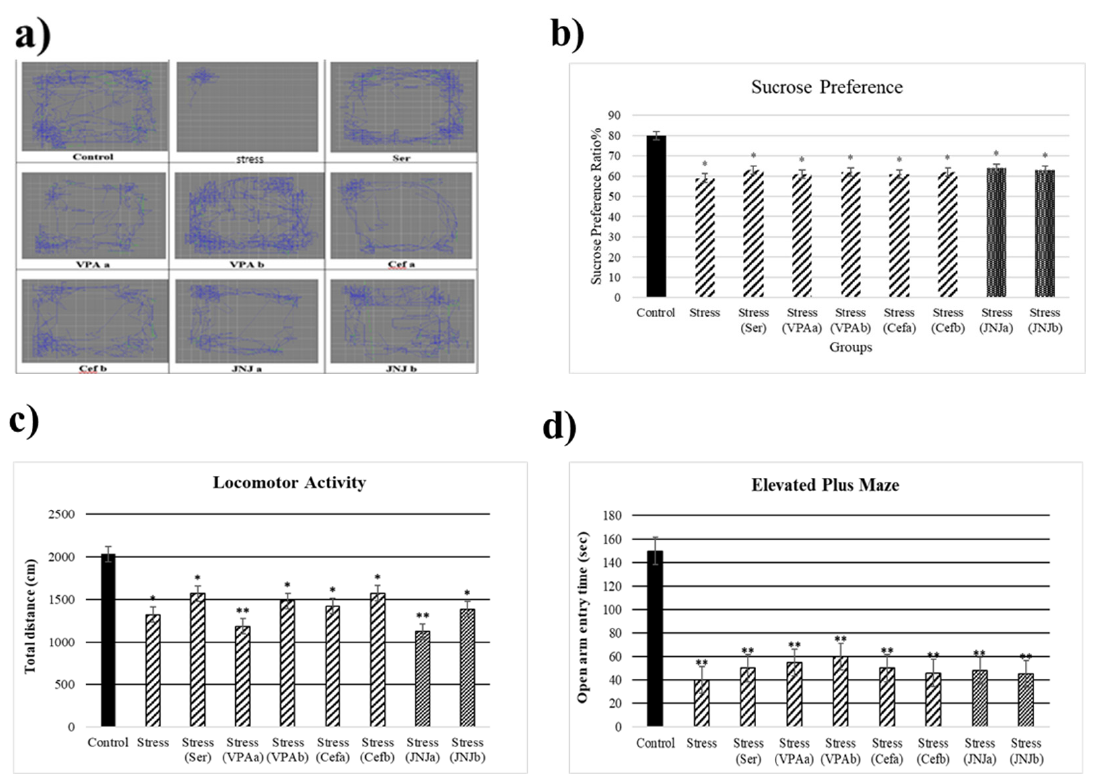
Figure 2. Behavioral performances of experimental groups exposed to stress 30 days. Locomotor activity: ( a ) schematic of traveled area, ( b ) Sucrose preference ratio, ( c ) locomotor activity, ( d ) Elevated plus-maze test: open arm entry time (s). One-way ANOVA, * p < 0.05, ** p < 0.001 compared with the Control group.